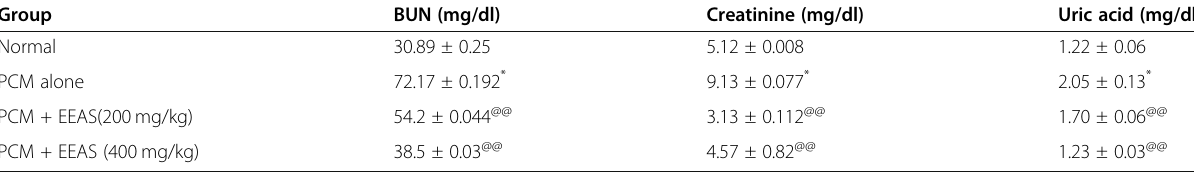
Table 1 Effect of EEAS on BUN, creatinine, and uric acid on PCM-induced nephrotoxicity in rats Group